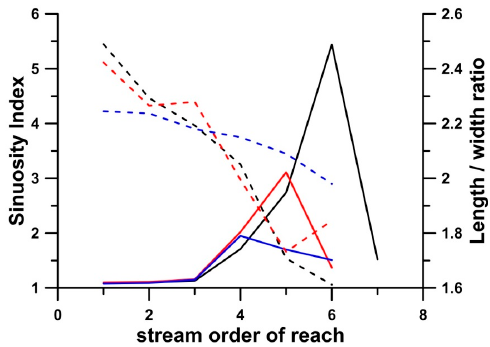
Figure 7. The mean sinuosity index (black line for LRW, red line for NoRW, and blue line for NsRW) of and length/width ratio (black dash line for LRW, red dash line for NoRW, and blue dash line for NsRW) of landslide cases in the three watersheds.